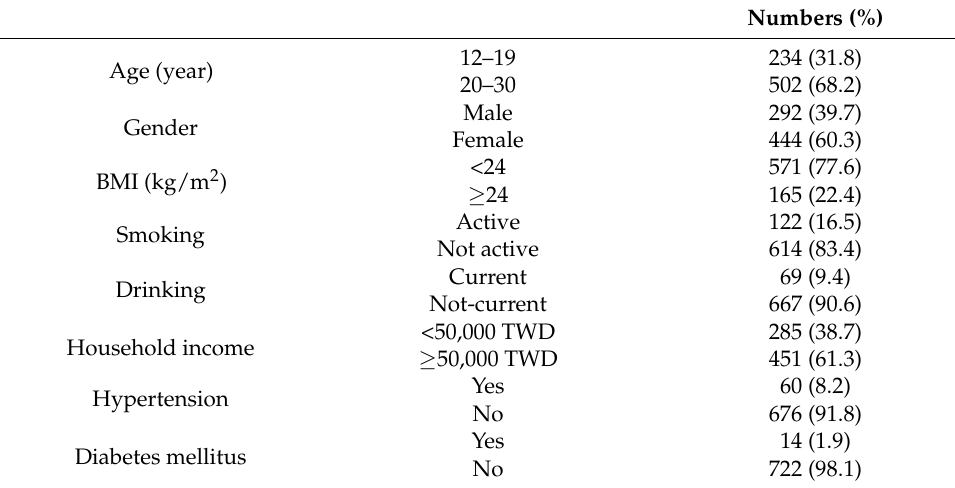
Table 1. Demographic data and metal exposure variables in the studied Taiwanese population (categorical variables) ( n =